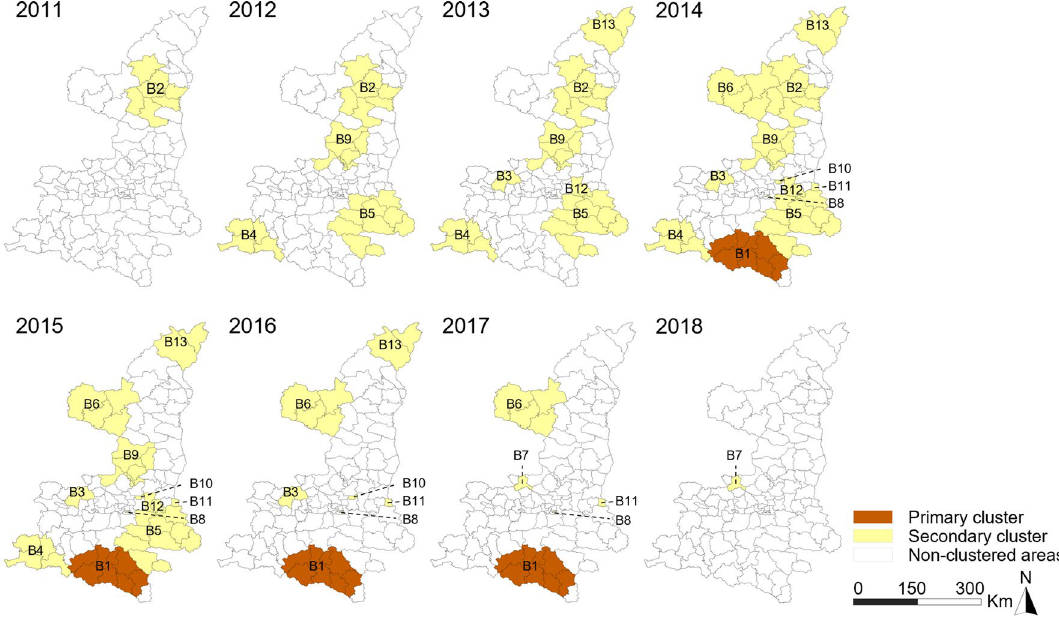
Figure 8. Spatiotemporal clusters of